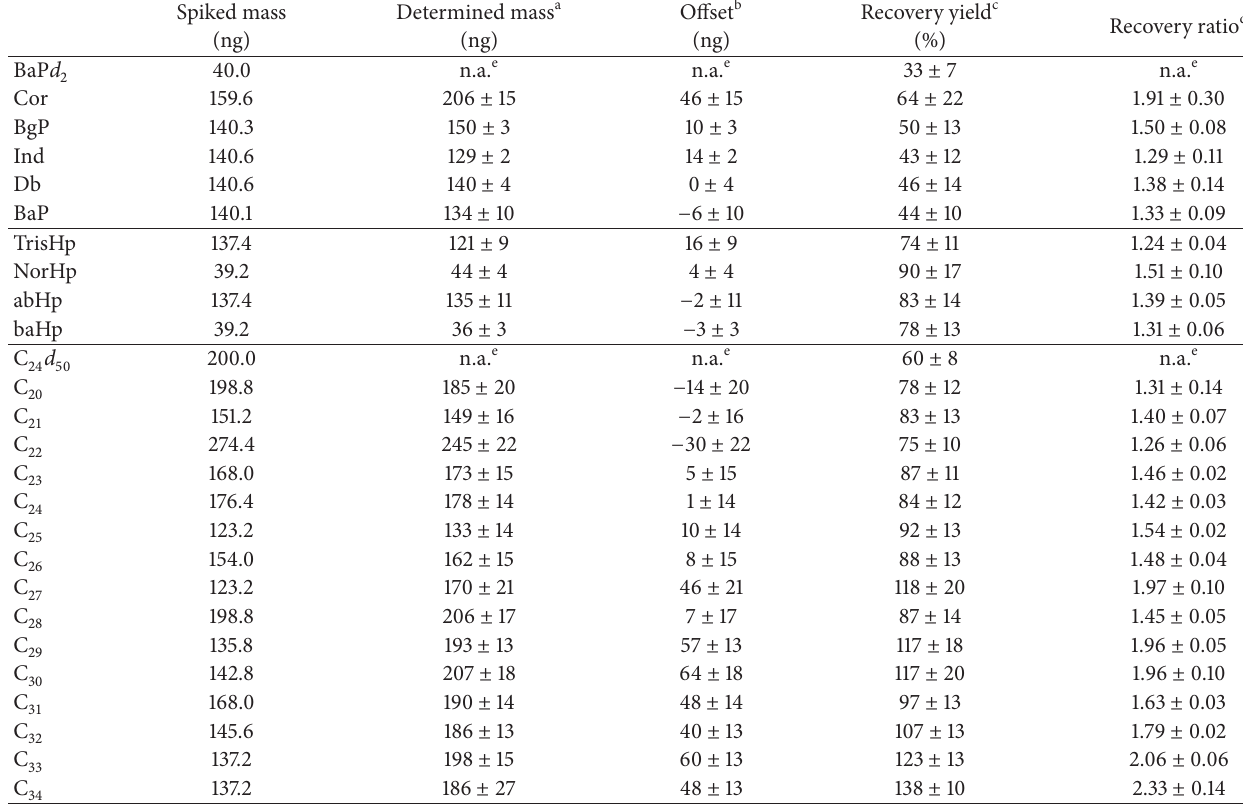
Table 3: Results of standard-spiked test.